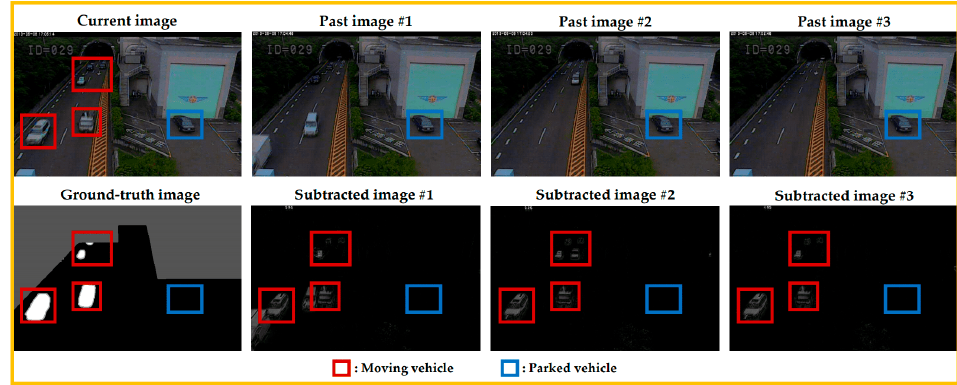
Figure 1. Use of temporal information by multiple difference images.